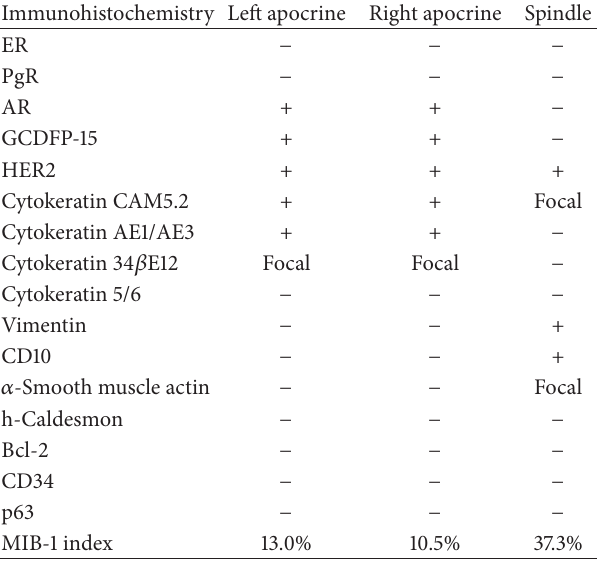
Table 1: Immunohistochemical results for each tumor